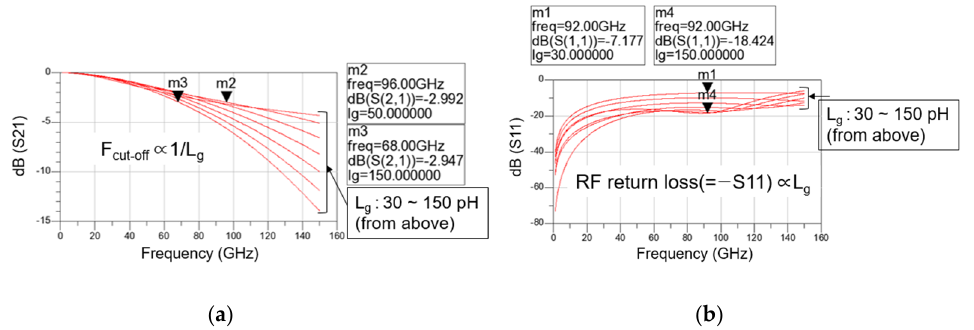
Figure 7. Simulated magnitudes of ( a ) S21 and ( b ) S11 in the total gate lines of a distributed cascode mixer versus RF according to gate line inductance.